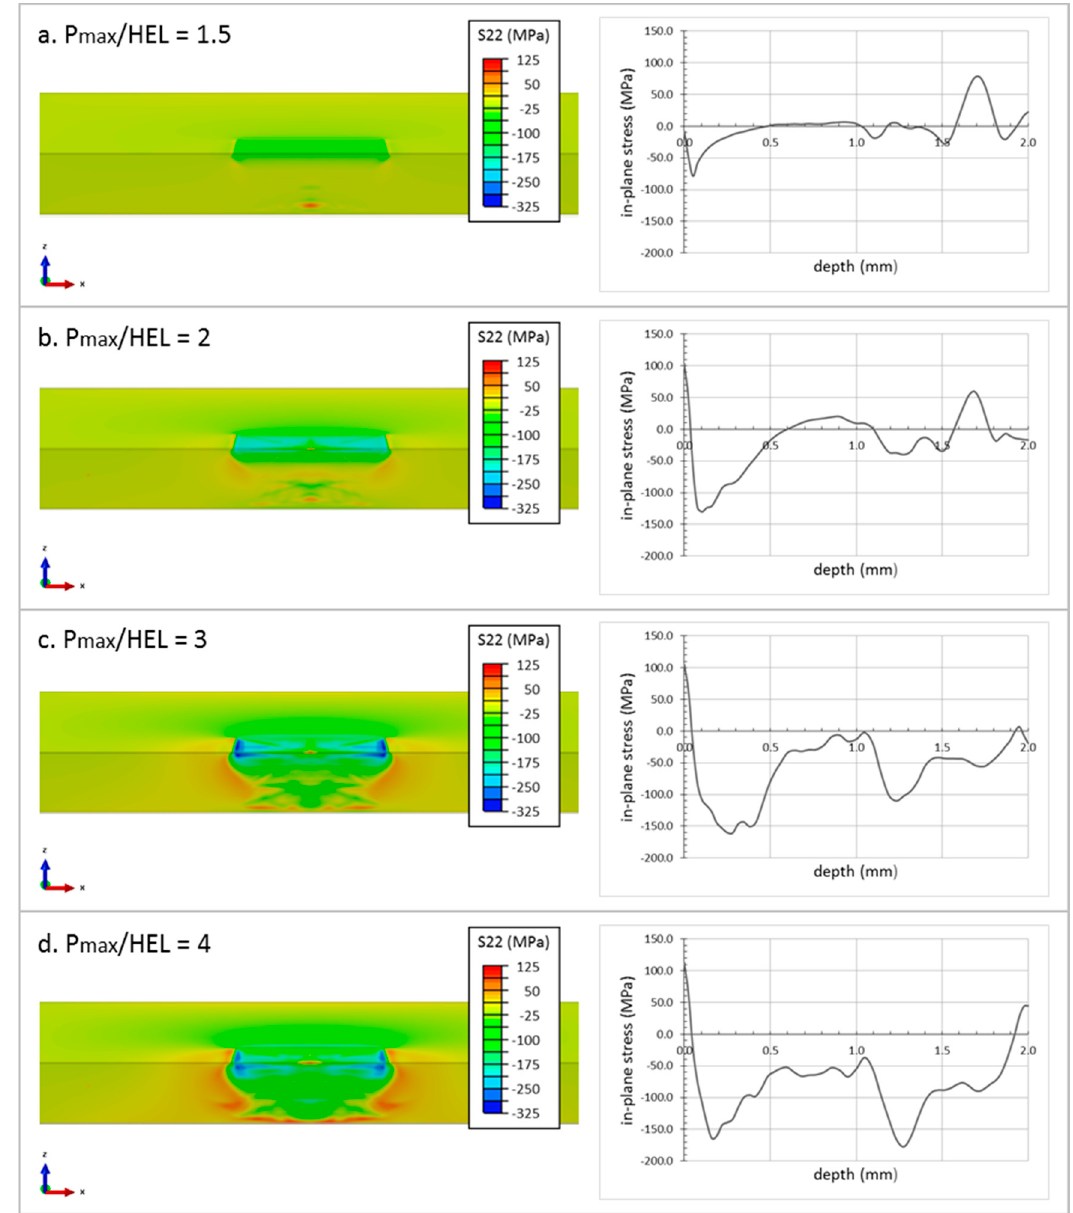
Figure 4. Finite element analysis (FEA)-computed in-plane residual stress from a single square laser peening (LP) shot (5 × 5 mm 2 ) on a 2-mm-thick Al2024-T351 plate at various pressure levels.